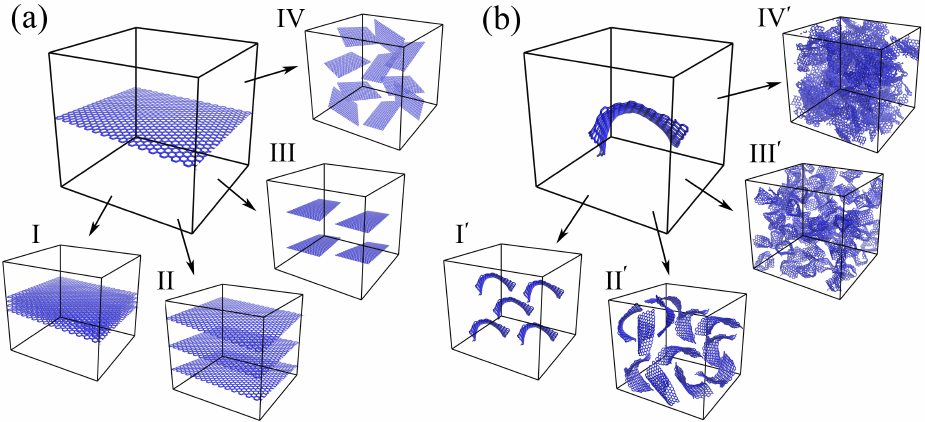
Figure 2. Schematic of metal/graphene composites with ( a ) planar graphene and ( b ) crumpled graphene. Metal atoms are not shown, graphene is shown in the blue